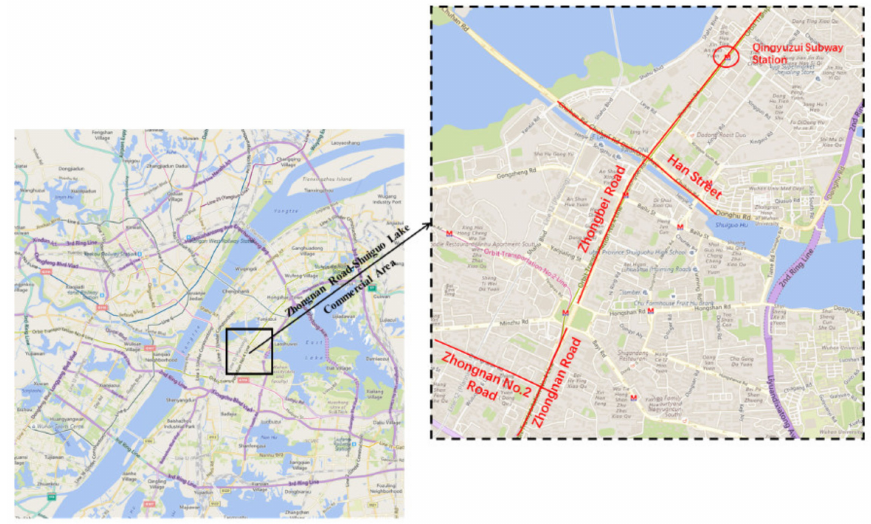
Figure 7. The map of the Zhongnan Road–Shuiguo Lake commercial area (base map: Bing Map).